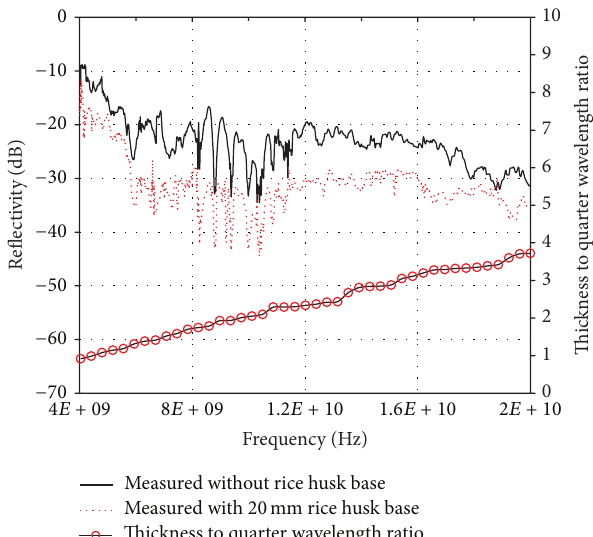
Figure 9: Measured bistatic, normal reflectivity performance of the hollow pyramids with reference to a metal plate along with the thickness-to-quarter-wavelength ratio based ontheactual dielectric properties.